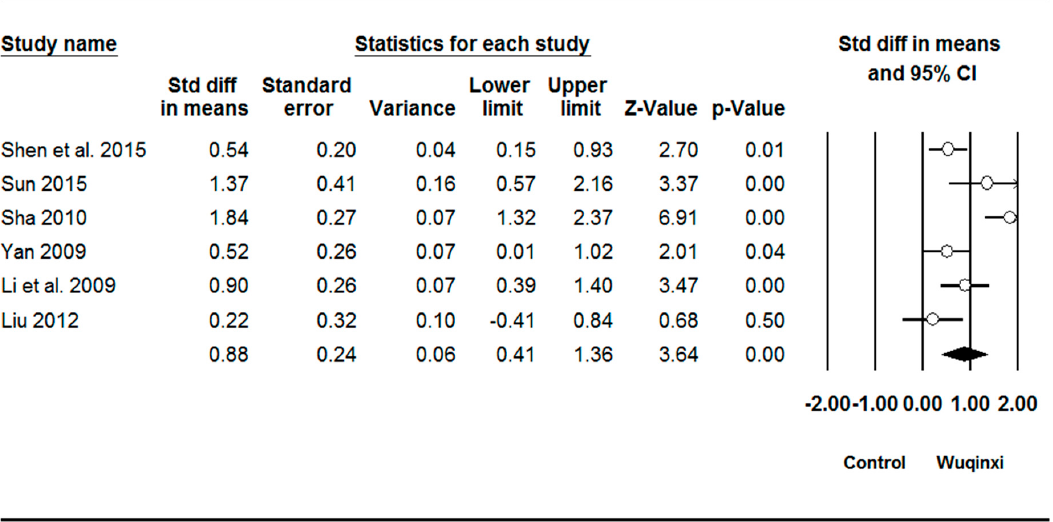
Figure 4. Effect of Wuqinxi on total plasma cholesterol. Effect size (95% CI) of each study is denoted by circle (black line). The mid-point of the circle represents the point effect estimate, meaning effect estimate for each study. The area of the circle represents the weight given to the study. The diamond below the studies represents the overall effect.